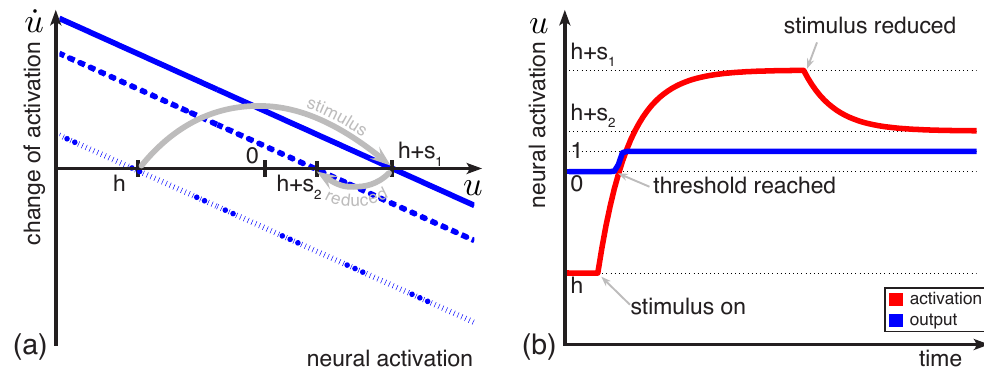
Figure 6: Dynamics of a single neural activation variable with stimulus (Equation 11). Panel (a) shows the phase plot for two different stim- ulus strengths s 1 (solid) and s 2 (dashed). The grey arrows indicate how the attractor is shifted from the dynamics without stimulus (dotted line) to new values determined by the stimulus strength. The example trajectory plotted in panel (b) shows how the activation variable u (red) tracks the stimulus by relaxing to the new attractor after each shift. The blue line shows the profile of the gated output σ ( u ) .